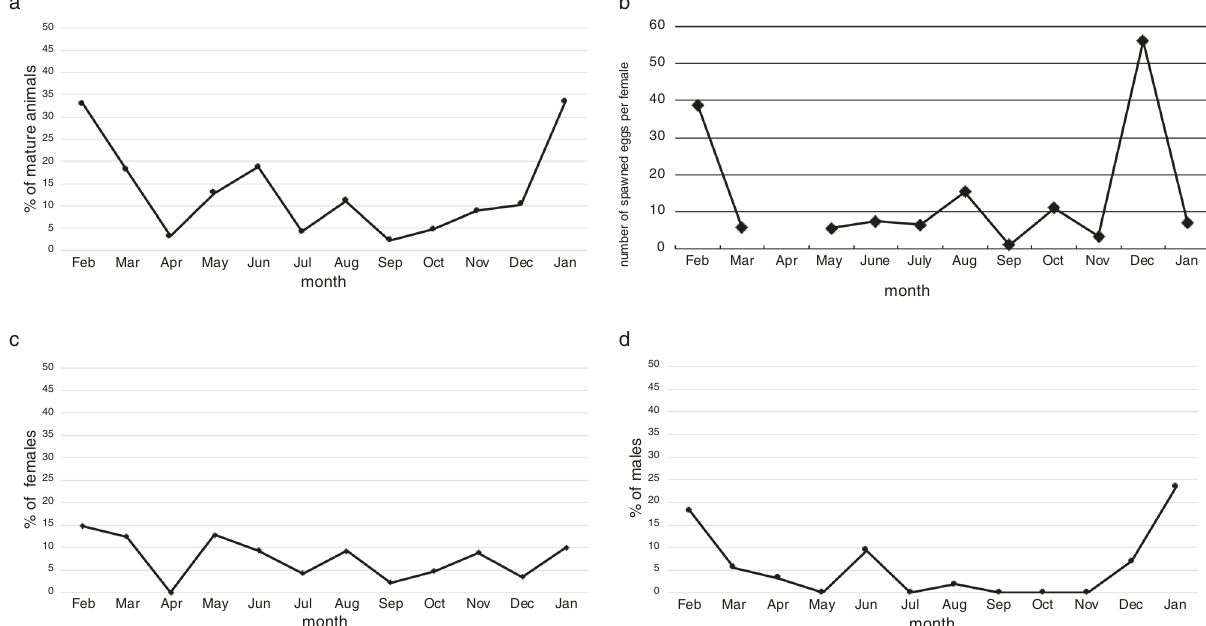
Fig. 3 Spawning induction of Xenoturbella bocki performed from 2006 to 2007. a Percentage of animals that spawned eggs or sperm in which spawning was induced ( n = 556). b Average number of spawned eggs per female ( n = 47). c Percentage of animals that spawned eggs in which spawning was induced ( n = 556). d Percentage of animals that spawned sperm in which spawning was induced ( n =